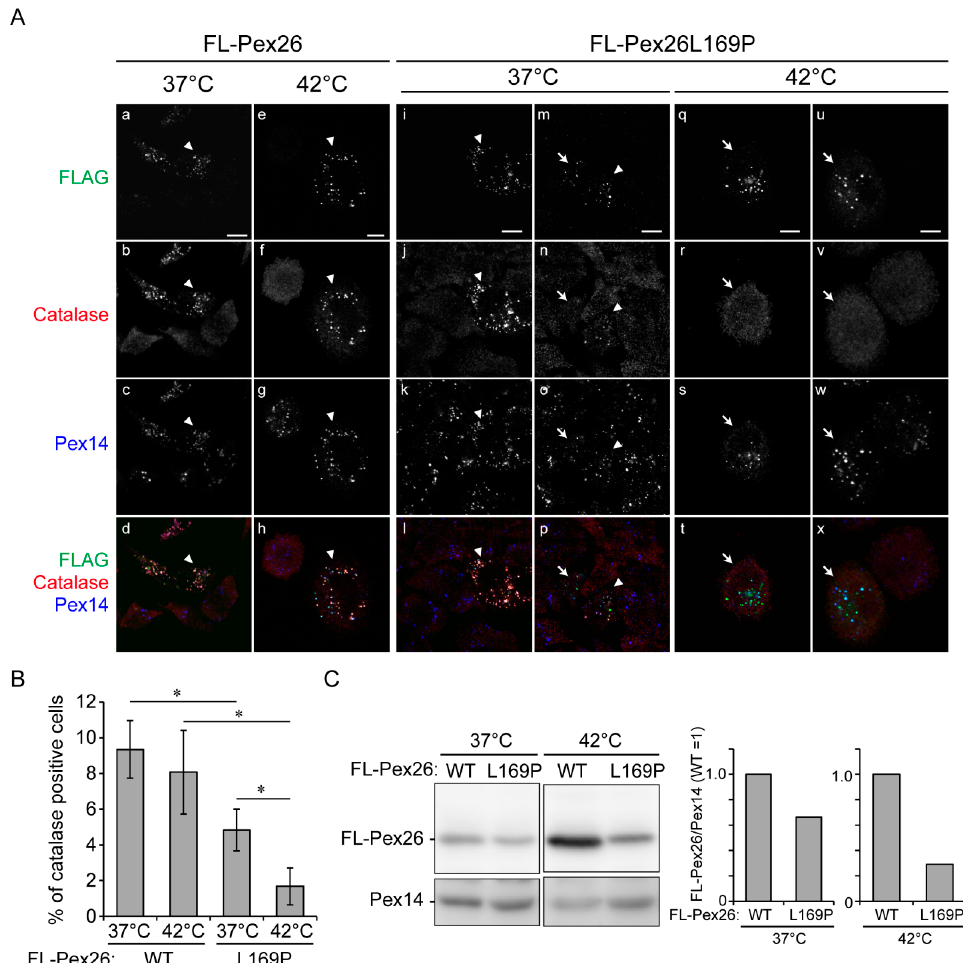
Figure 3. Dysfunction of Pex26-L169P. ( A ) pex26 CHO ZP167 cells transfected with FLAG -tagged human PEX26 and PEX26-L169P were cultured at 37 °C and 42 °C for 2 days and then stained with antibodies to FLAG (top panels: a, e, i, m, q, and u), a matrix protein catalase (middle upper panels: b, f, j, n, r, and v), and a membrane peroxin Pex14 (middle lower panels: c, g, k, o, s, and w). Merged views were also shown (bottom panels: d, h, l, p, t, and x). Scale bars, 10 µm. Arrowheads indicate FLAG-, catalase-, and Pex14-positive cells, whereas arrows show cells positive with FLAG and Pex14. ( B ) In A, catalase- and FLAG-positive cells were counted and represented as percentages of total cells counted (500 cells each, n = 3). Data represent means ± S.D. ( n = 3). * p < 0.05; Tukey-Kramer test. ( C ) Expression level of FLAG-Pex26 and FLAG-Pex26-L169P was analyzed by SDS-PAGE of respective cell lysates and immunoblotting with anti-FLAG antibody (left). Pex14, a loading control. The amounts of both FLAG-Pex26 variants were represented by normalizing the levels of FLAG-Pex26 variants with Pex14 in respective cell lysates (right).